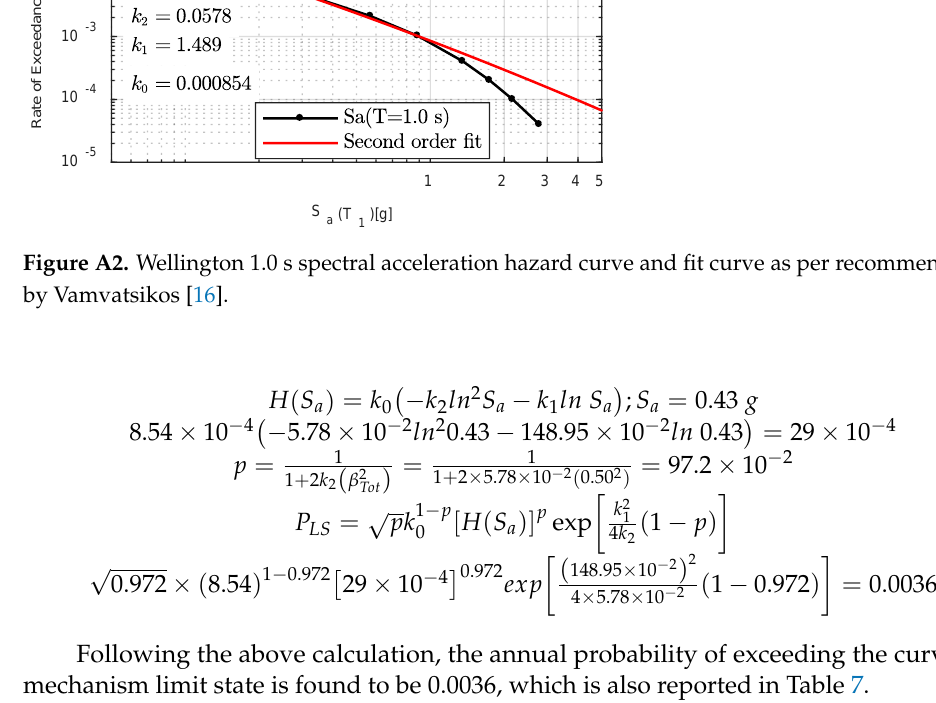
Following the above calculation, the annual probability of exceeding the curvature mechanism limit state is found to be 0.0036, which is also reported in Table